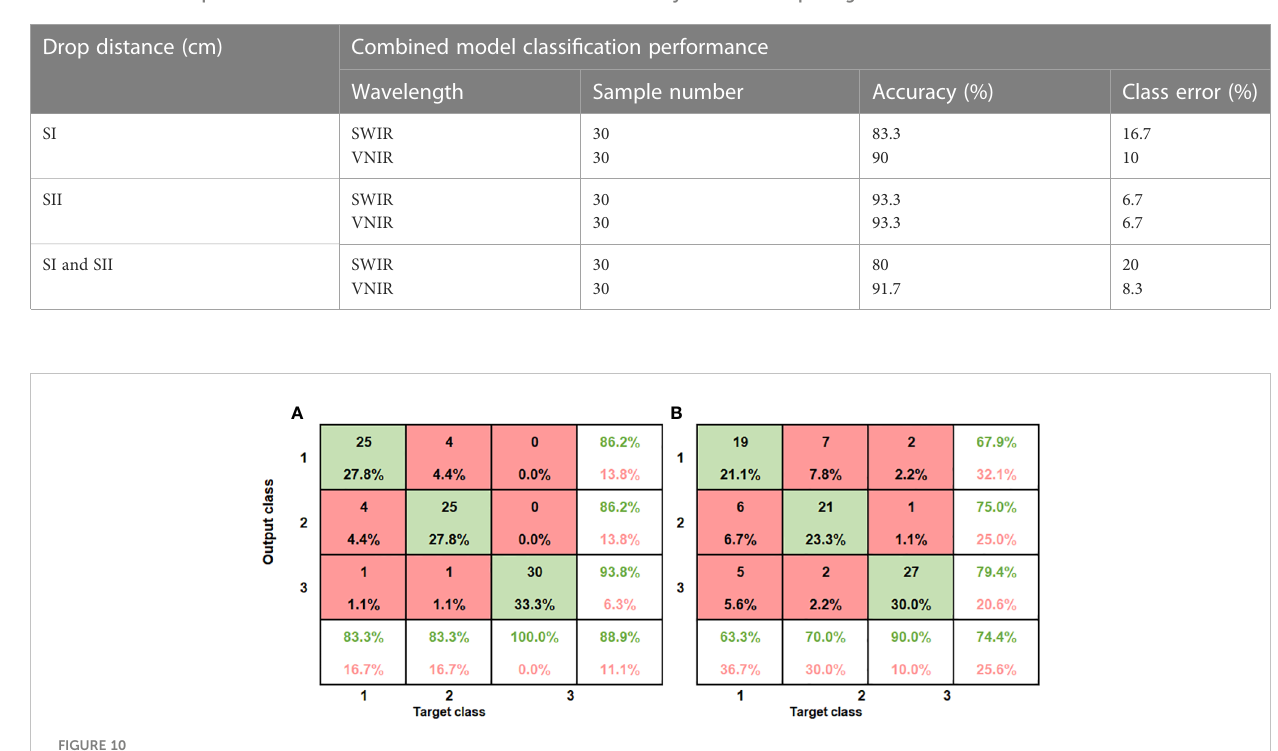
FIGURE 10 Summary of confusion matrices obtained for the combined ANN model for both SWIR and VNIR input data (A) SWIR classi fi cation performance (B) VNIR classi fi cation performance.